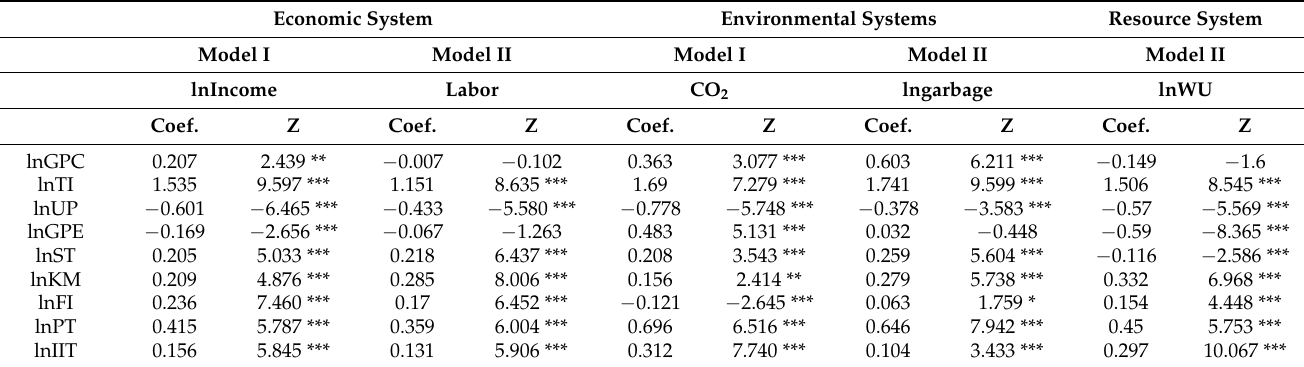
Table 5. Tobit regression results for external driving forces controlling regional tourist-hotel eco-efficiency. Economic System Environmental Systems Resource System Model